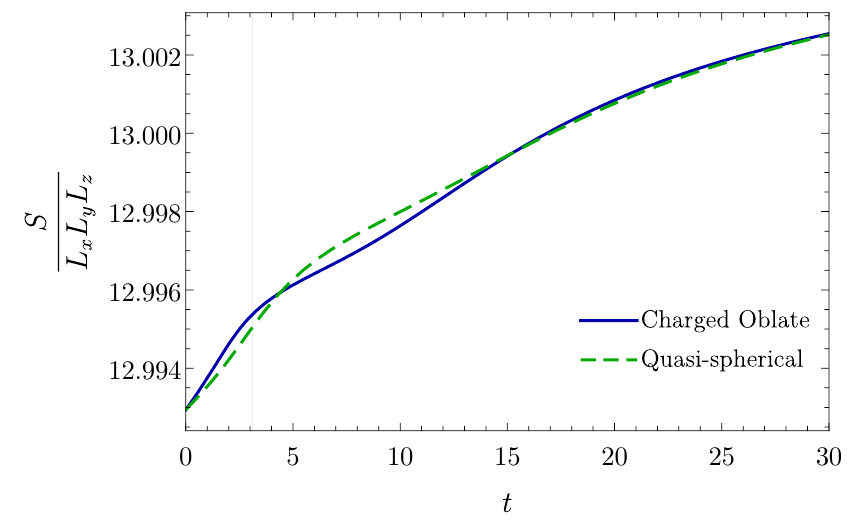
Figure 11 . Total entropy normalized by the volume as a function of time for a charged oblate with δx = 2 and quasi-spherical blob collisions. The width of the initial blobs is chosen in such a way that the end state is the same. The measured slopes are (3 . 29 · 10 − 4 , 2 . 86 · 10 − 4 )